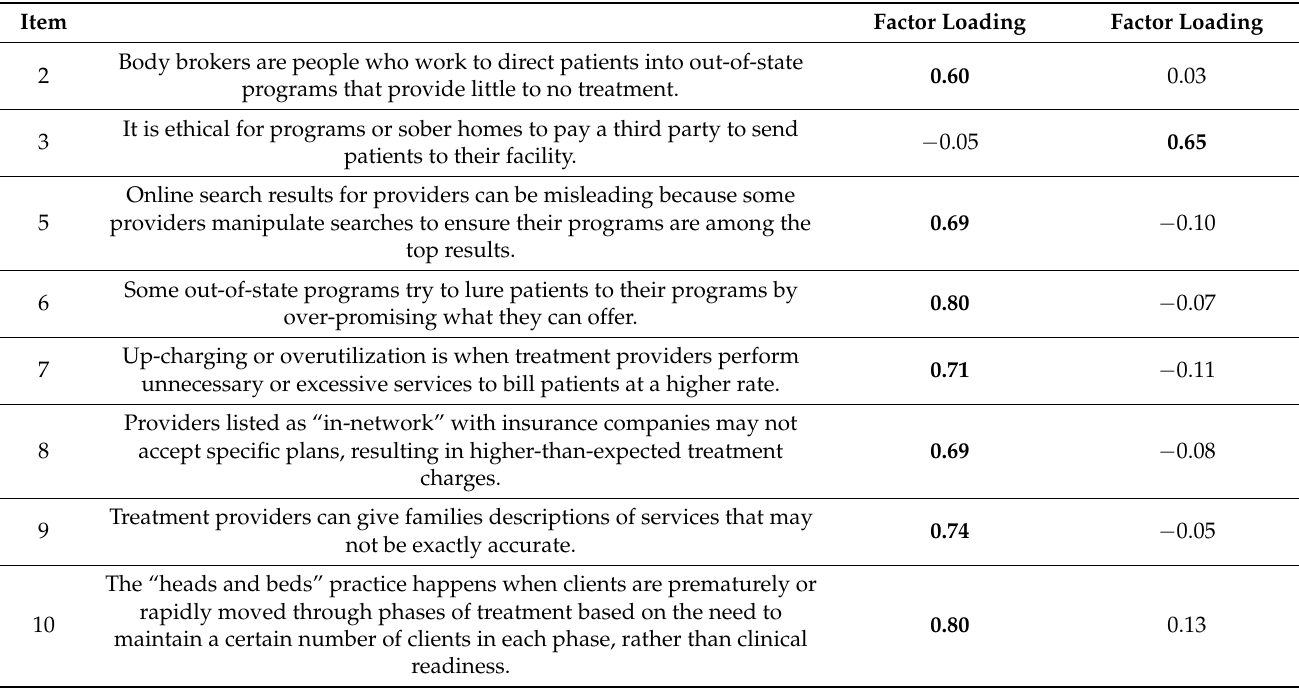
Table 3. Rotated factor loadings of